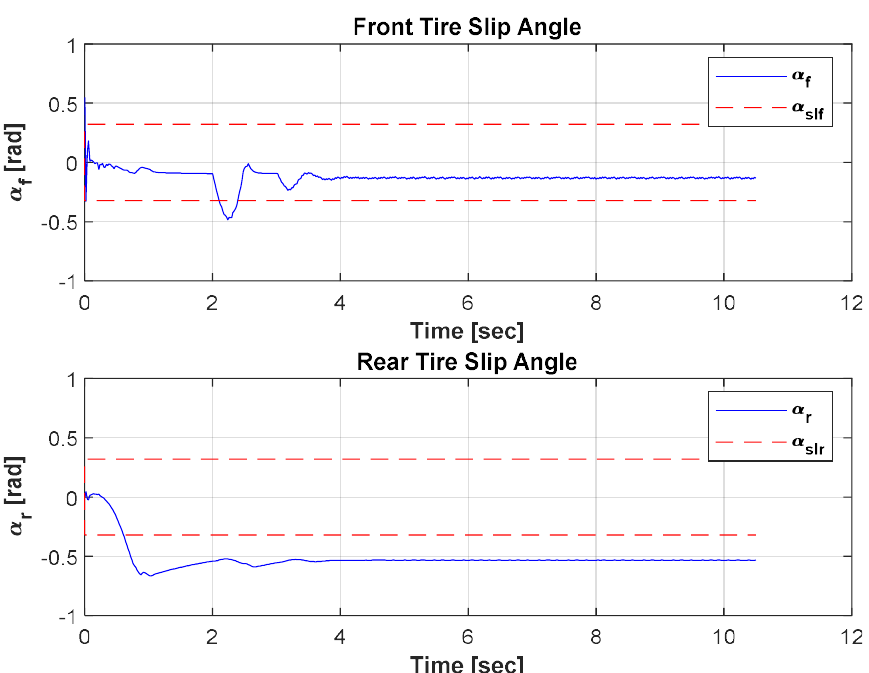
Figure 17. Front and rear tire slip angles during the drift maneuver. The solid blue lines in the upper and lower panels present the slip angles of the front and rear wheels, respectively, and the dotted red line shows the tire saturation threshold.